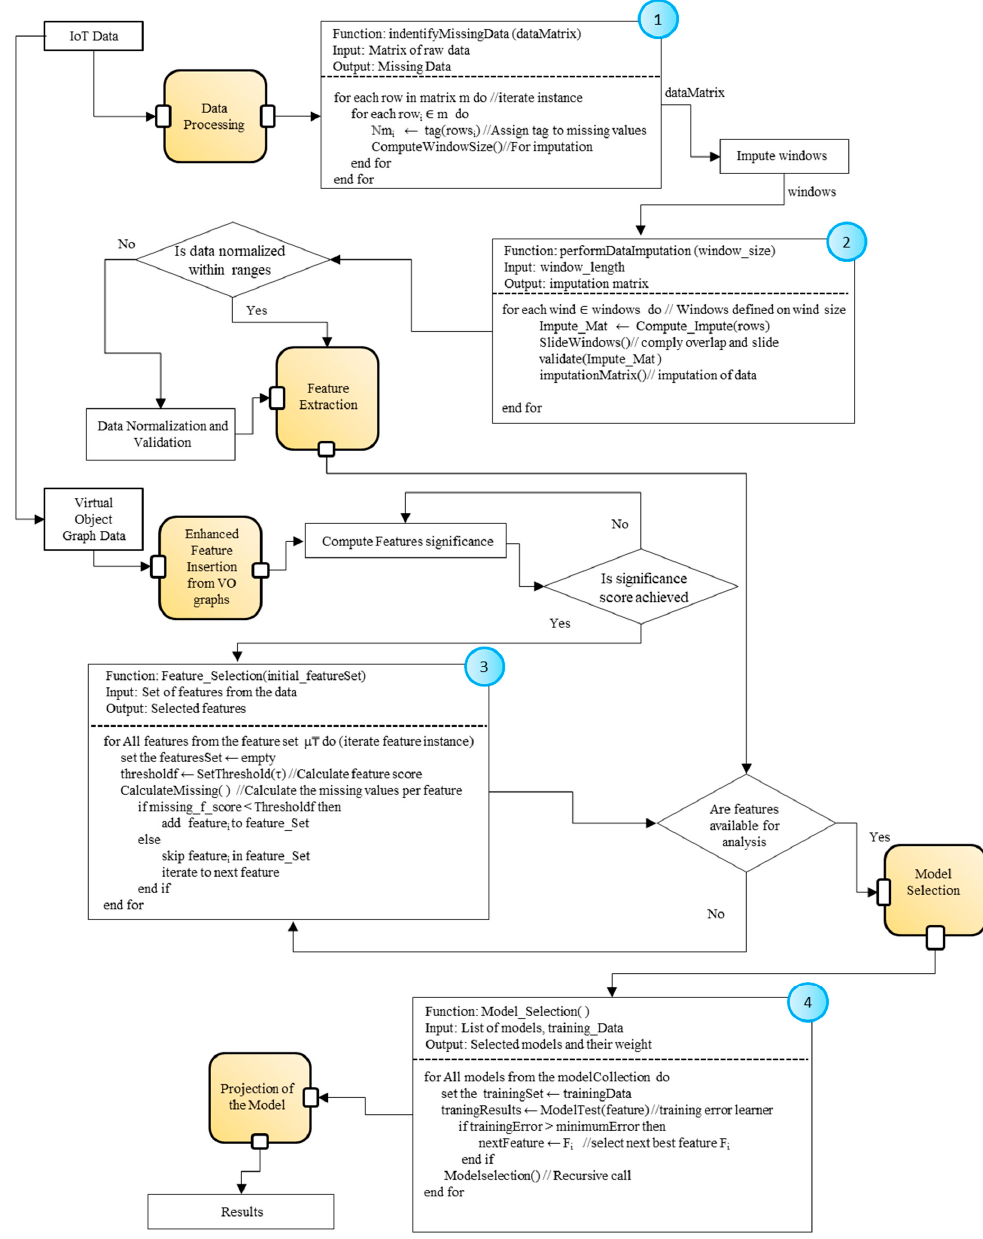
Figure 8. Analytic processes flow diagram. Table 2. Notations used in the algorithm.